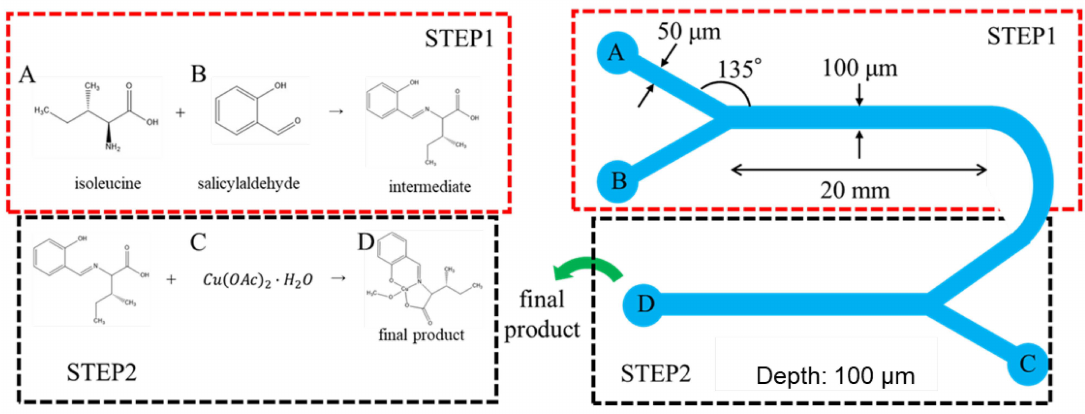
Figure 7. Synthesis flow in a microfluidic